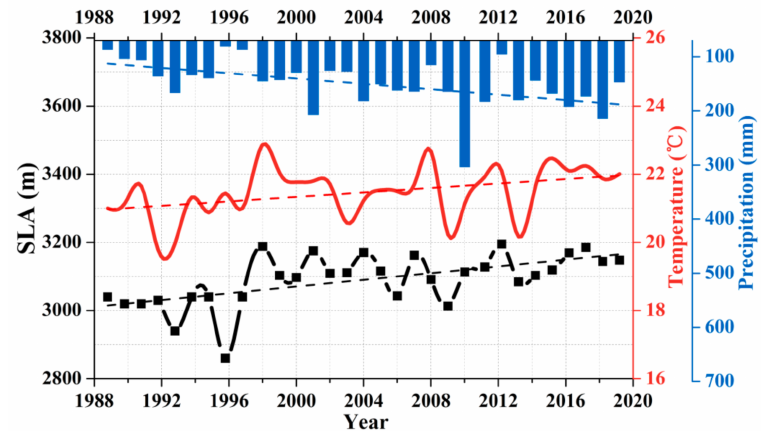
Figure 7. Cold season (September–May) precipitation (blue), summer mean temperature (red), and glacier SLA (black) across the Altai Mountains during the 1989–2019 period. Dashed lines indicate the best-fit linear trends for each dataset.